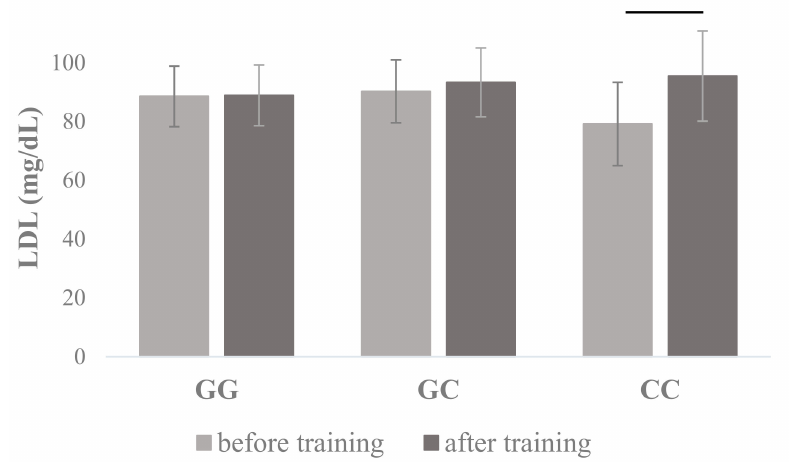
Figure 1. Changes in plasma low-density lipoproteins (LDL) concentrations measured before and after the completion of the 12-week training program in carriers of di ff erent PPARA I7 rs4253778 genotypes. The values are mean ±